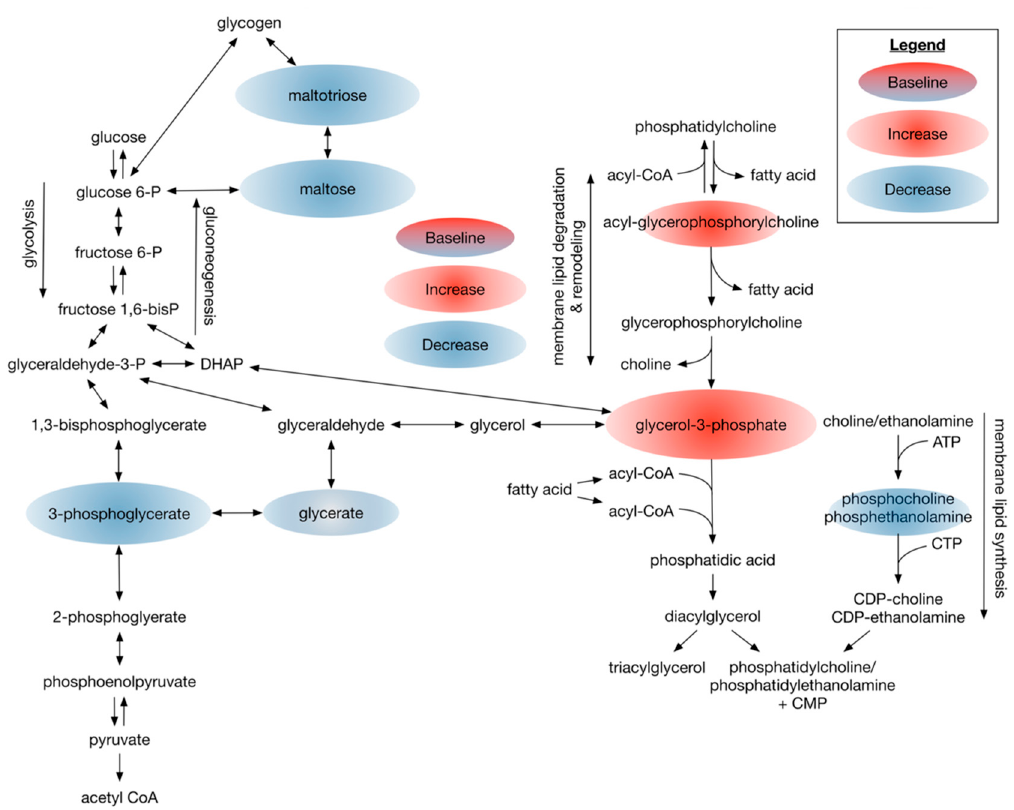
Figure 4. Glycerolipid and glucose metabolism changes overlaid on a metabolic map. The size of each colored bubble is proportional to the fold change (increase, red; decrease, blue). The baseline bubble in the legend corresponds to a fold change of 1. glucose-6-P, glucose-6-phosphate; fructose-6-P, Fructose-6-phosphate; fructose 1,6 bisP, fructose 1,6, bisphosphate; glyceraldehyde-3-P, glyceraldehyde-3-phosphate; DHAP, Dihydroxyacetone phosphate; acyl-CoA, acetyl coenzyme A; ATP, adenosine triphosphate; CTP, Cytidine triphosphate; CDP-choline, cytidine diphosphate-choline; CDP-ethanolamine, cytidine diphosphate-ethanolamine; CMP, cytidine monophosphate. Table 5. Metabolites of glucose and glycerolipid metabolism.